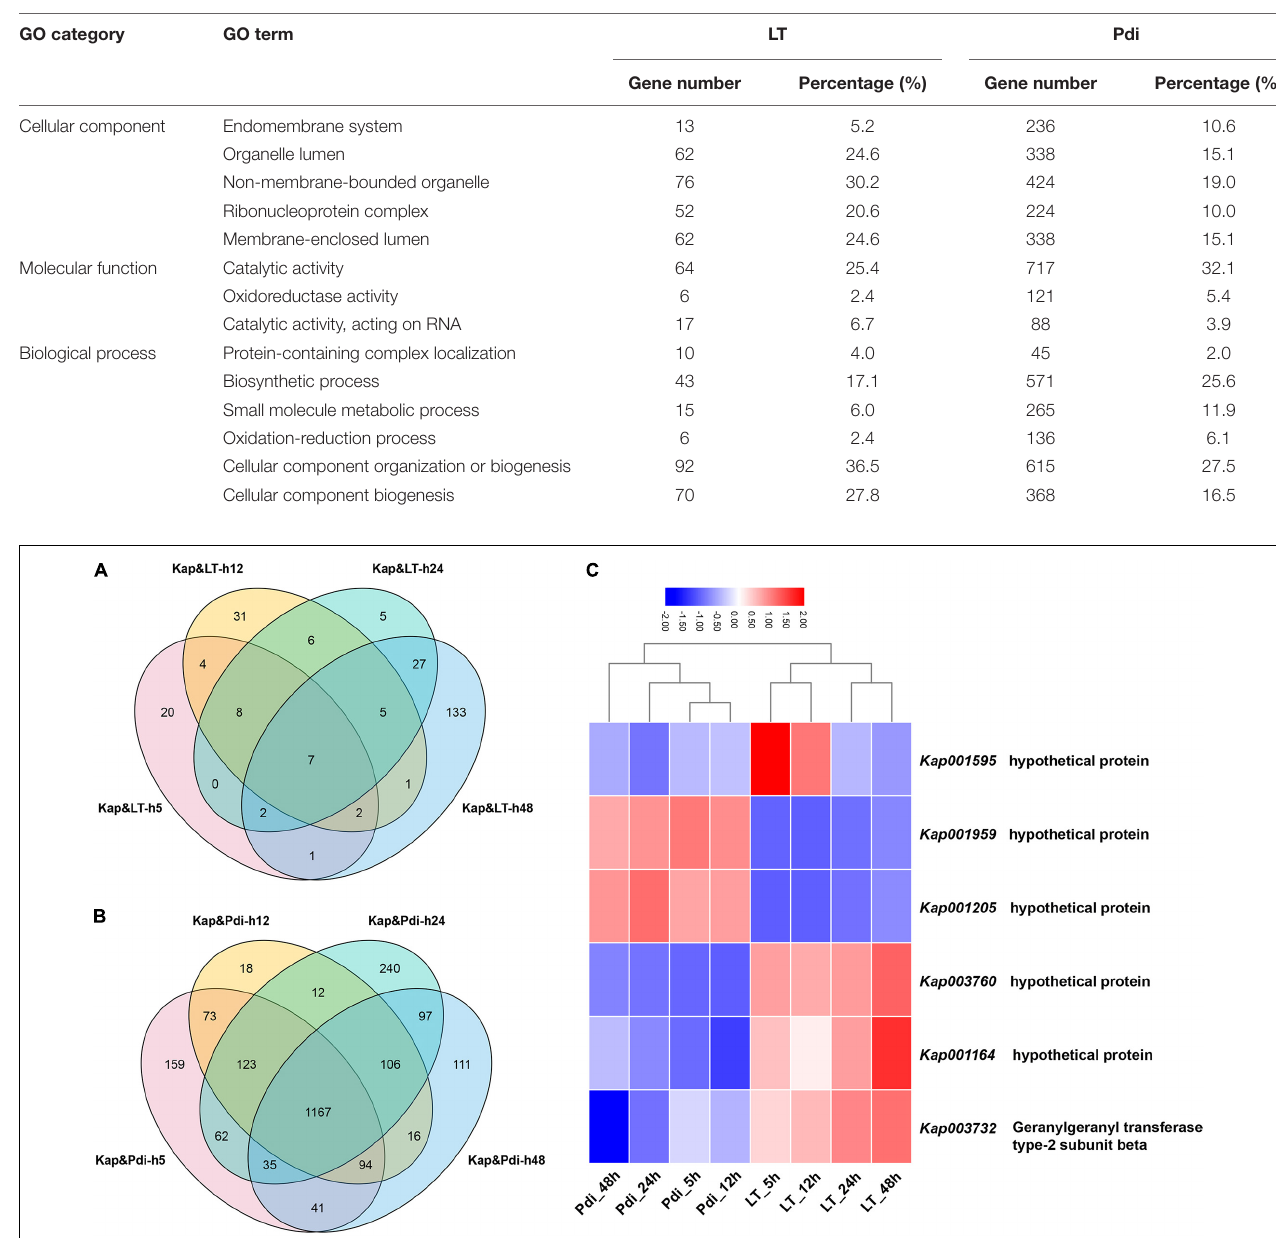
TABLE 3 | Number and proportion of genes in each GO category between LT and Pdi.